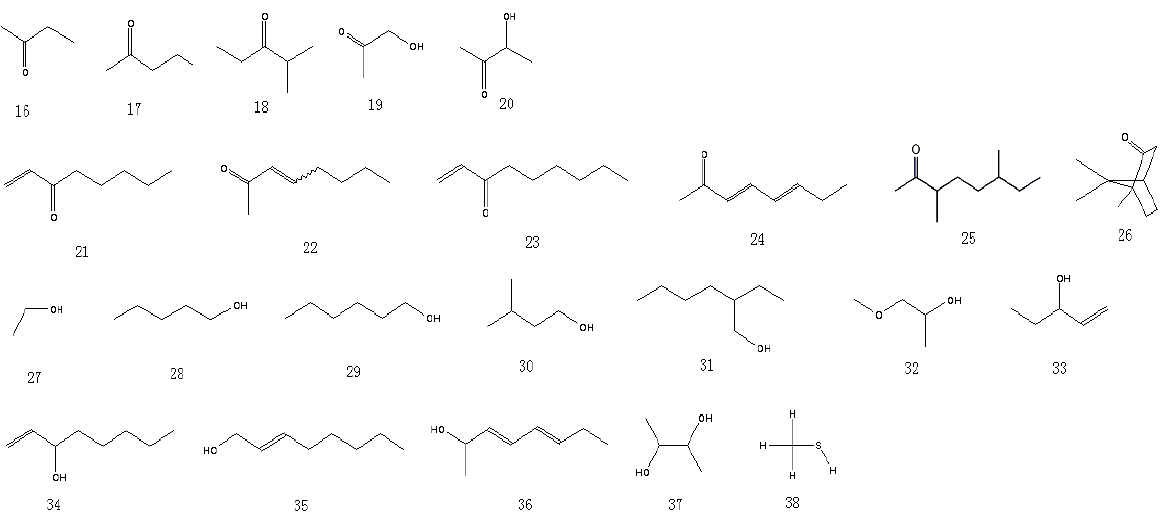
Figure 2. Structures of the ketones and alcohols in Jinhua ham.